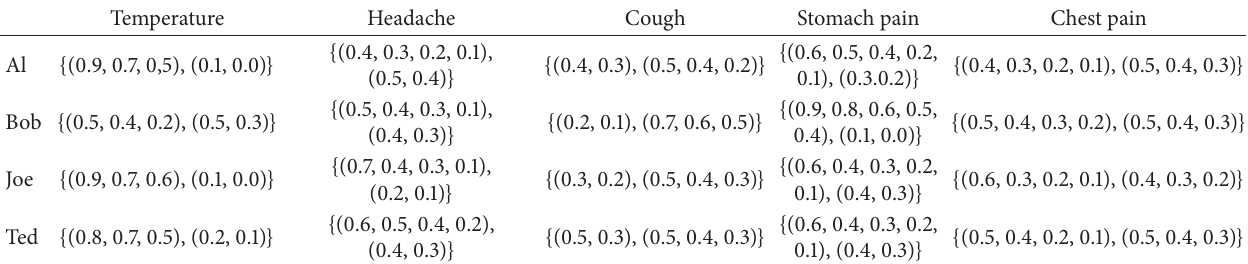
Table 2: Symptoms characteristic of the considered patients.